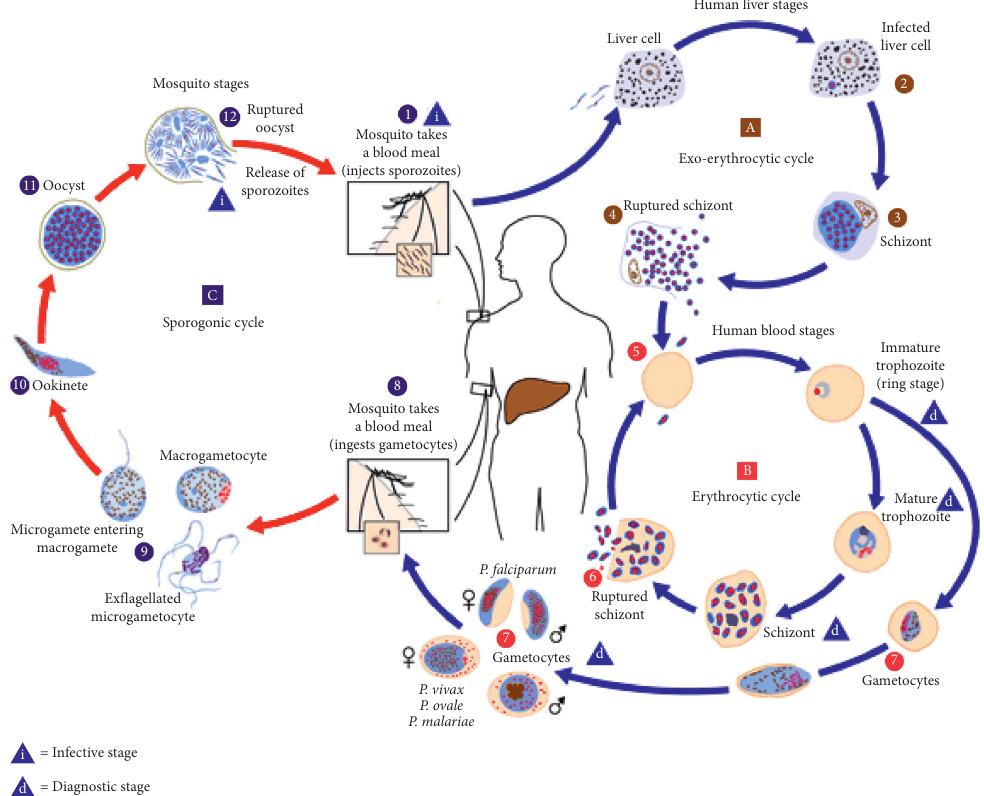
Figure 1: Life cycle of malaria parasites (adopted from